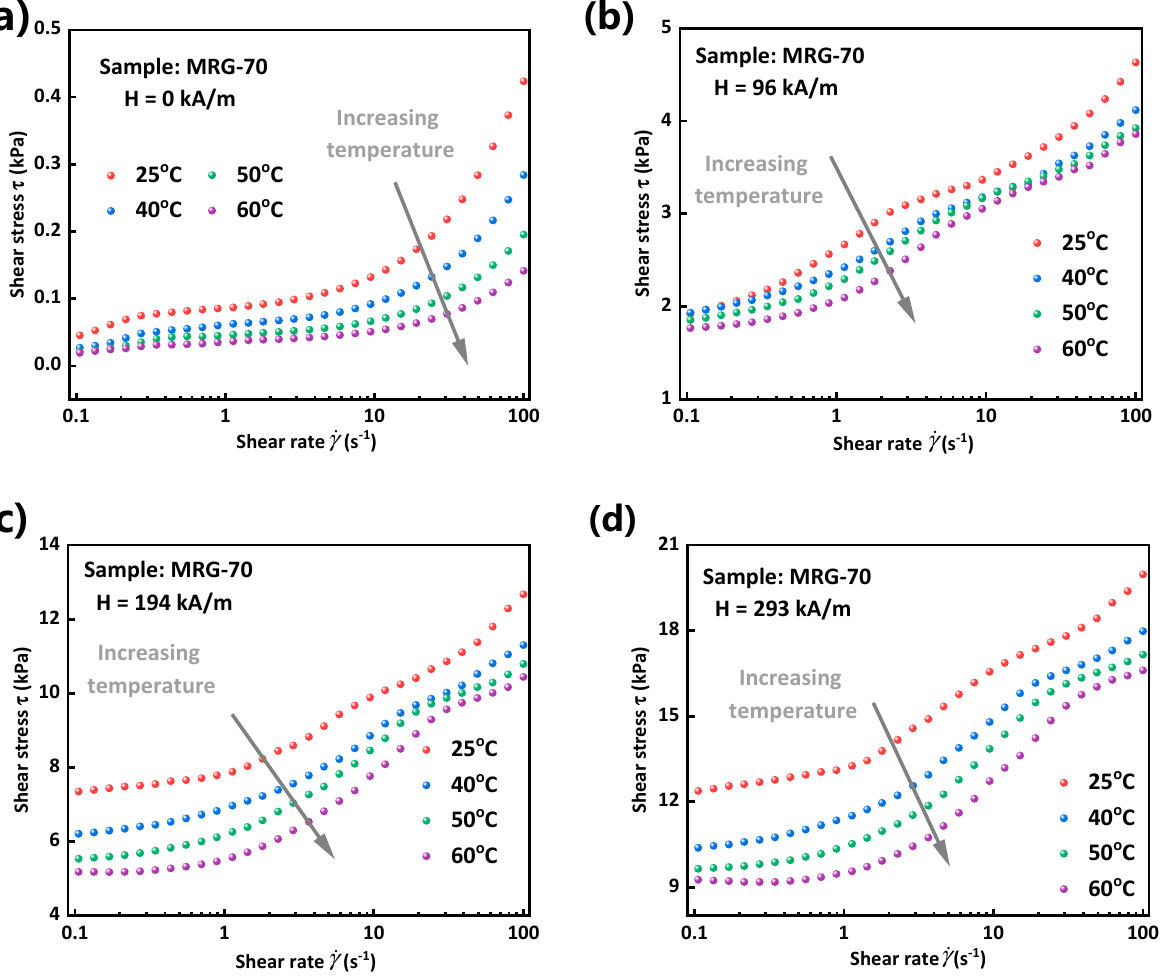
Figure 3. Shear stress as a function of shear rate under different temperatures and magnetic field strengths. 0 kA/m ( a ), 96 kA/m ( b ), 194 kA/m ( c ) and 293 kA/m ( d ).